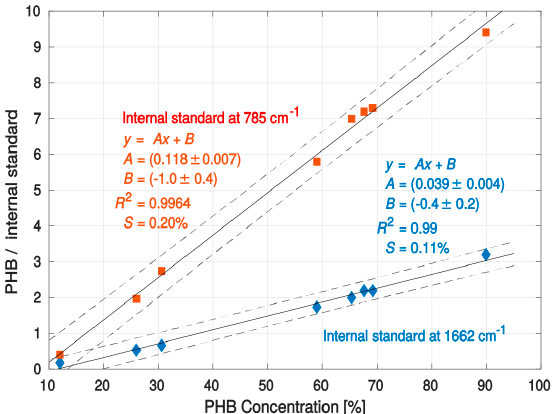
Figure 2. Calibration plot for PHB in Cupriavidus necator over a PHB concentration range of 12%–90% (by mass). The upper calibration curve (red squares) emission line at 787 cm − 1 (DNA) was used as an internal standard. The bottom calibration curve was constructed using a line at 1662 cm − 1 (Amide I) as an internal standard. The dashed curves show a 95% confidence band of linear fit. Parameters describing the calibration curves are shown in the figure (including 95% error interval). R 2 is the coefficient of determination. S is the mean square error. The calibration curve provides an excellent fit to the data over the region of interest. Normalized intensities of emission lines used for calibration and cultivation conditions and media used for growing bacteria are listed in Table 1.